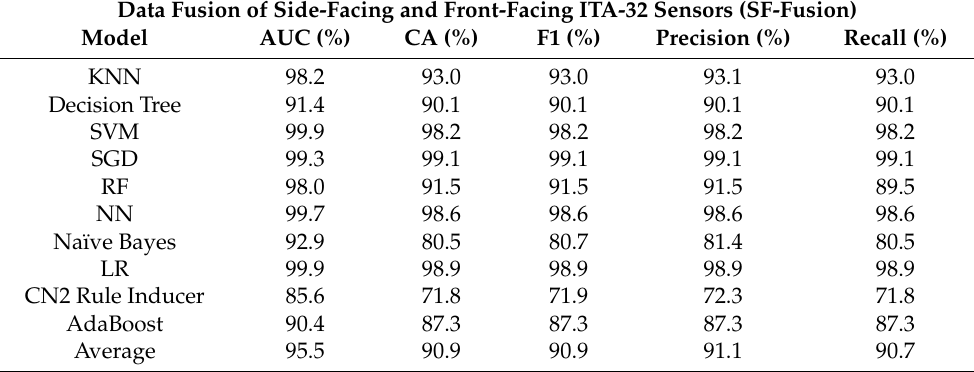
Table 4. Evaluation results of the front and side-facing ITA-32 thermal sensor data using a 10-fold cross-validation and the average of classes. The fused data were obtained during sprained ankle rehabilitation exercises.